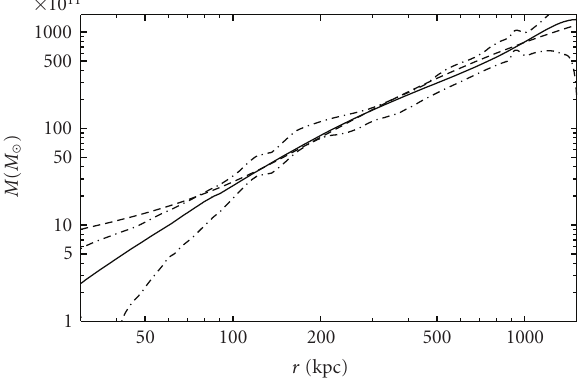
Figure 11: As the above cases, for cluster Abell 1413.